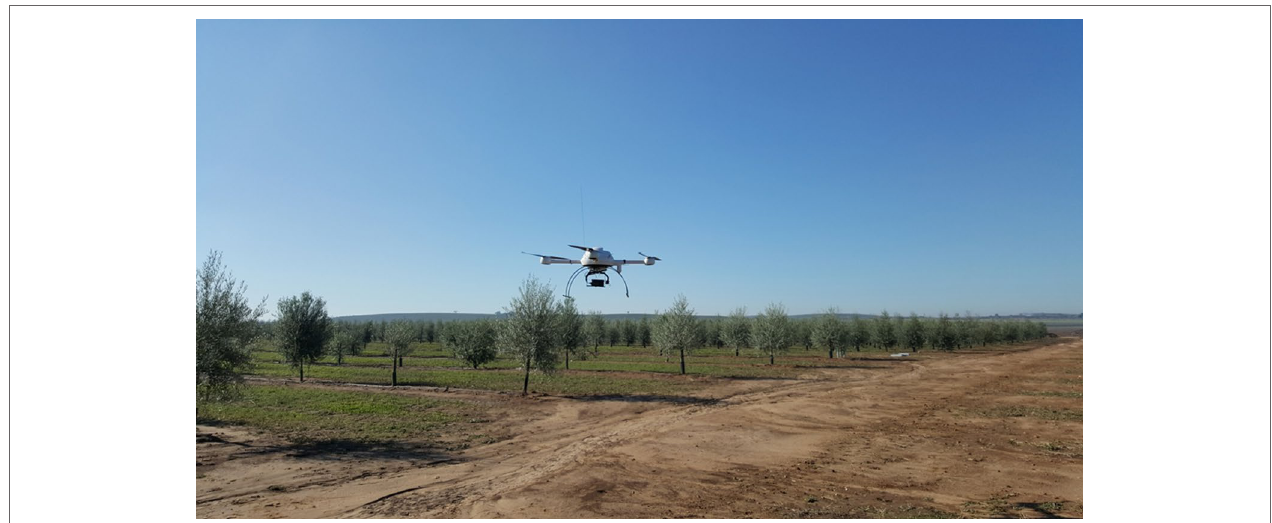
FIgUrE 2 | The MD4-1000 UAV flying over the intensive trial in the second studied date (January 2018).